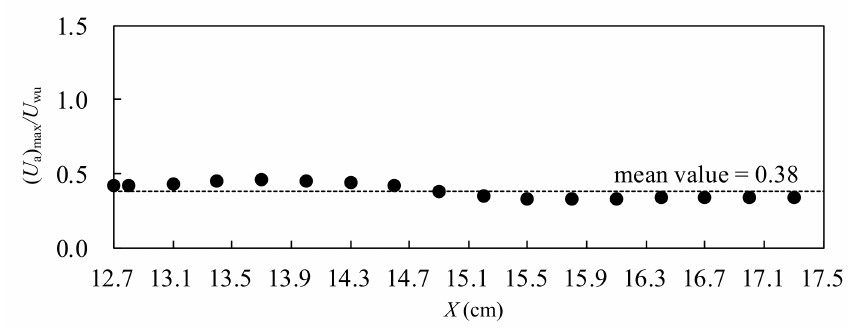
Figure 23. Variation of ( U a ) max / U wu with X .